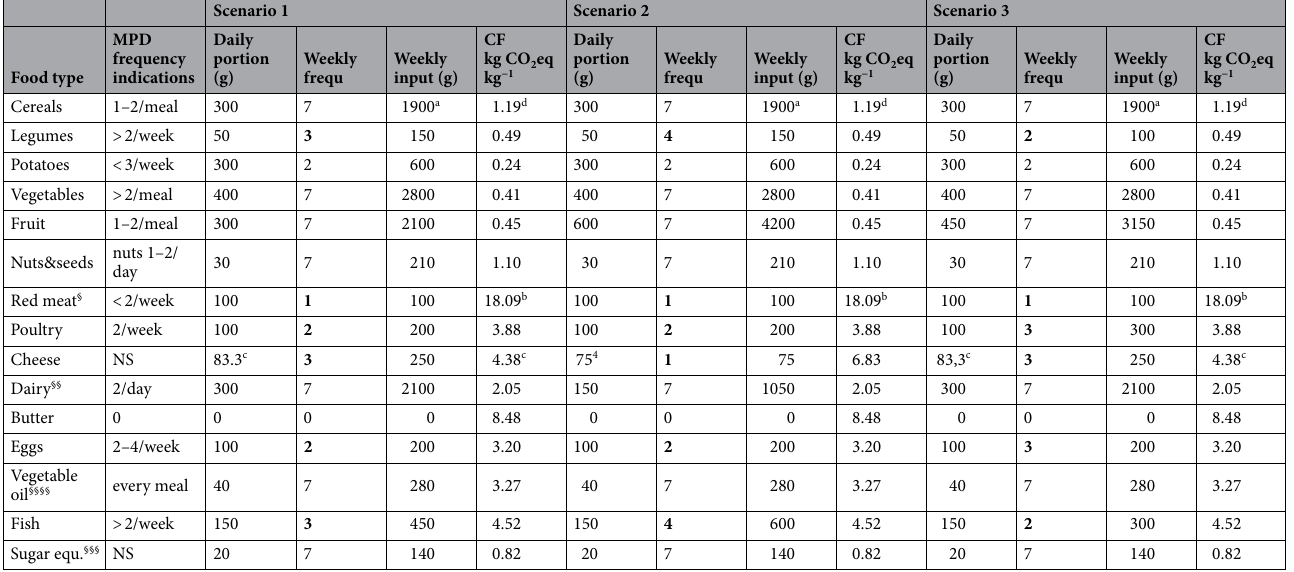
Table 1. Mediterranean dietary pattern scenarios used to define the MD reference diet in this study. Three patterns of MD differing for weekly frequency distribution of protein sources, within the recommended limits provided by the Mediterranean pyramid diet (MPD) 10,19 and complying with nutritional indications 20–24 . Portions and weekly frequency have been calibrated for an average EU citizen energy requirement 21 . The carbon footprint (CF) values reported in this table represent weighted CFs based on the relative proportion of each food item present in each specific group (see methods for more details). Single food item CF values were extracted from the SU-Eatable LIFE database 14,15 . § Red meat is the sum of beef meat, mutton and goat meat, and pork meat, §§milk and white yogurt, §§§sugar equivalents in jam or honey, §§§§Olive oil is the fat source suggested by MDP. a 2 portions per week of pasta or bread are substituted with 2 portion of potatoes, considering an equivalent ratio bread: potato of 1: 3 (g fresh weight). b CF of red meat is the average of the